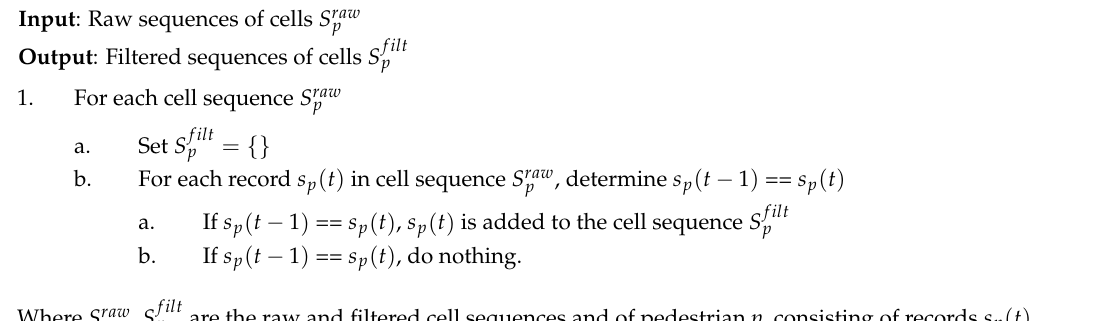
Algorithm 2 : Description of the consecutive hit algorithm, which translates the raw cell sequence to a cell sequence of consecutive visited cells